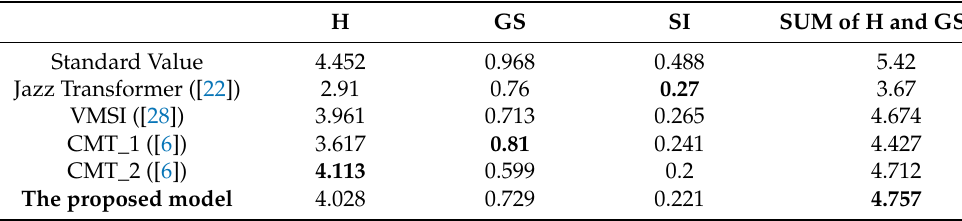
Table 3. Objective comparison of music generated by different